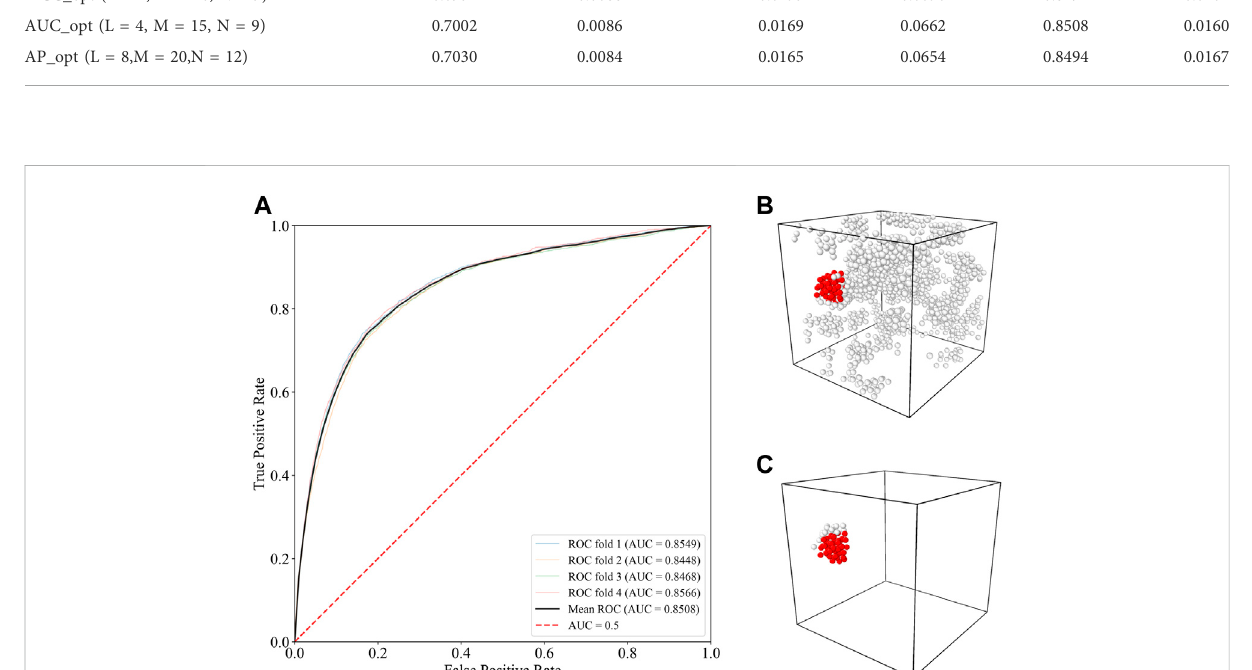
FIGURE 2 Predictionresultsofthemachinelearningmodel: (A) Thereceiver operatingcharacteristic(ROC)curveofthetestspecimens. (B) Thepredicted sheartransformedatomswhichthemodelclassi fi edaslabel1.Theredatomsaretruepositiveatomsandthewhiteatomsaretheatomspredictedas label 1 but that are actually label 0. (C) The true shear transformed atoms which we labeled as 1. The red atoms are both true and correctly predicted (true positive atoms) and the white atoms are shear transformed atoms that the model incorrectly classi fi ed as label